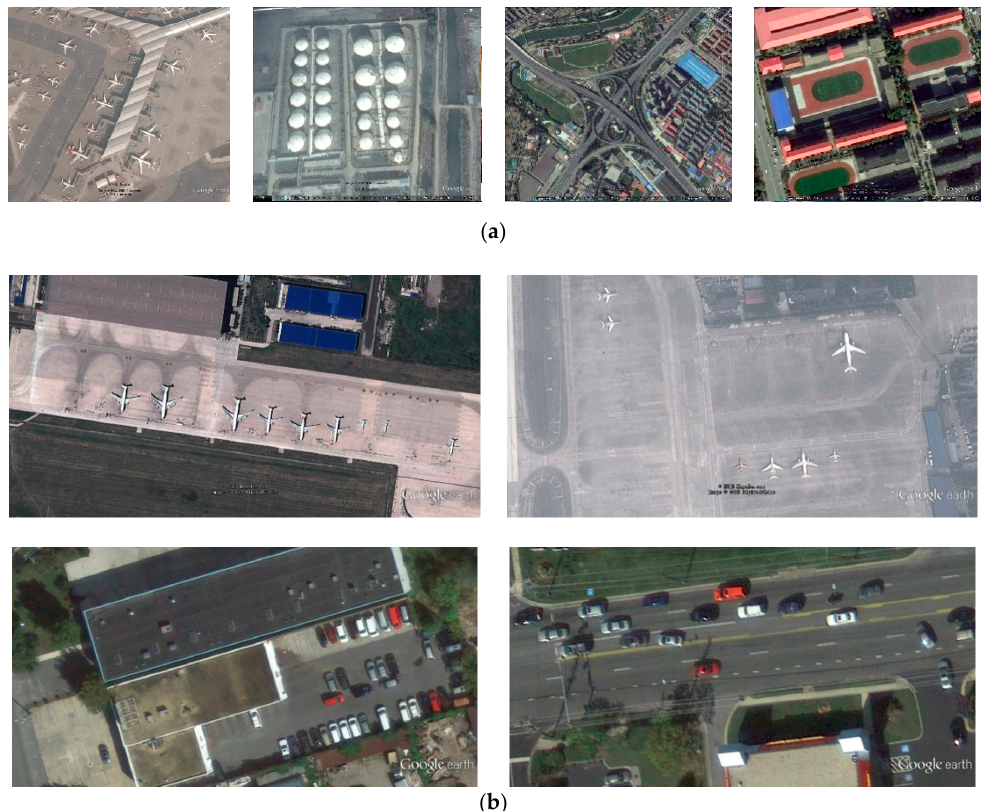
Figure 7. The samples of the datasets: ( a ) the samples of remote sensing object detection (RSOD) dataset and ( b ) the samples of dataset of object detection in aerial images ( UCS-AOD) dataset.